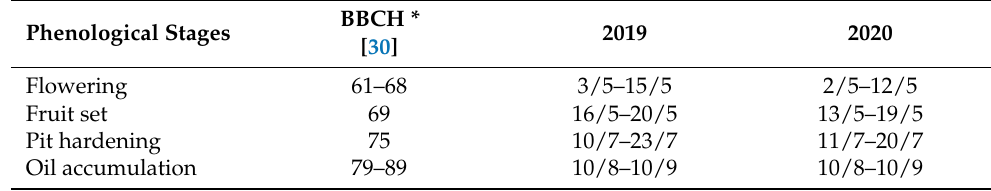
Table 2. Dates of phenological stages in olive cv. Coratina during 2019 and 2020. Phenological